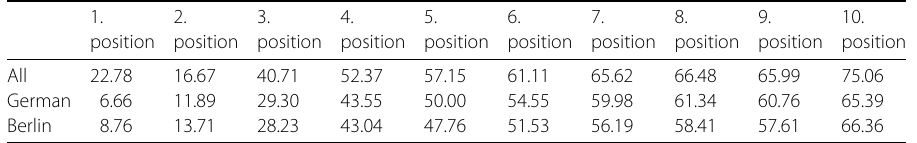
Table 4 Average pairwise deviation (in %) at each rank searching for a person in the respective dataset for all result lists, German results and results originated in Berlin